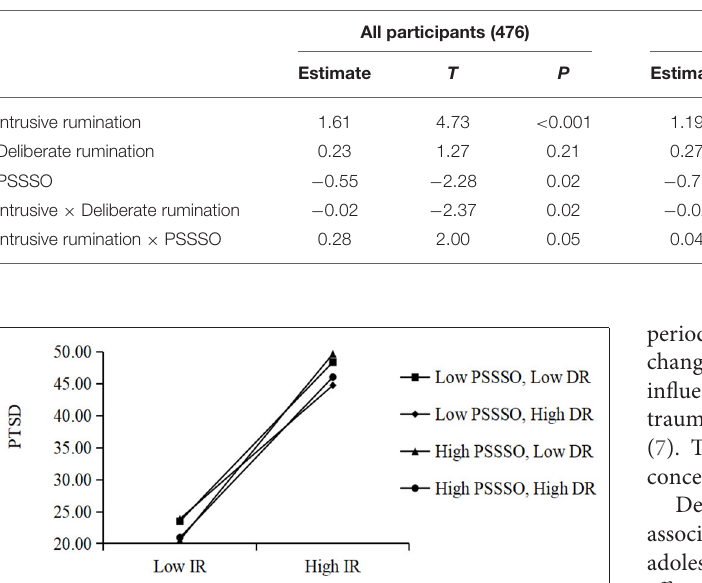
TABLE 4 | Linear regression analysis: main and moderate factors associated with PTSD symptoms.